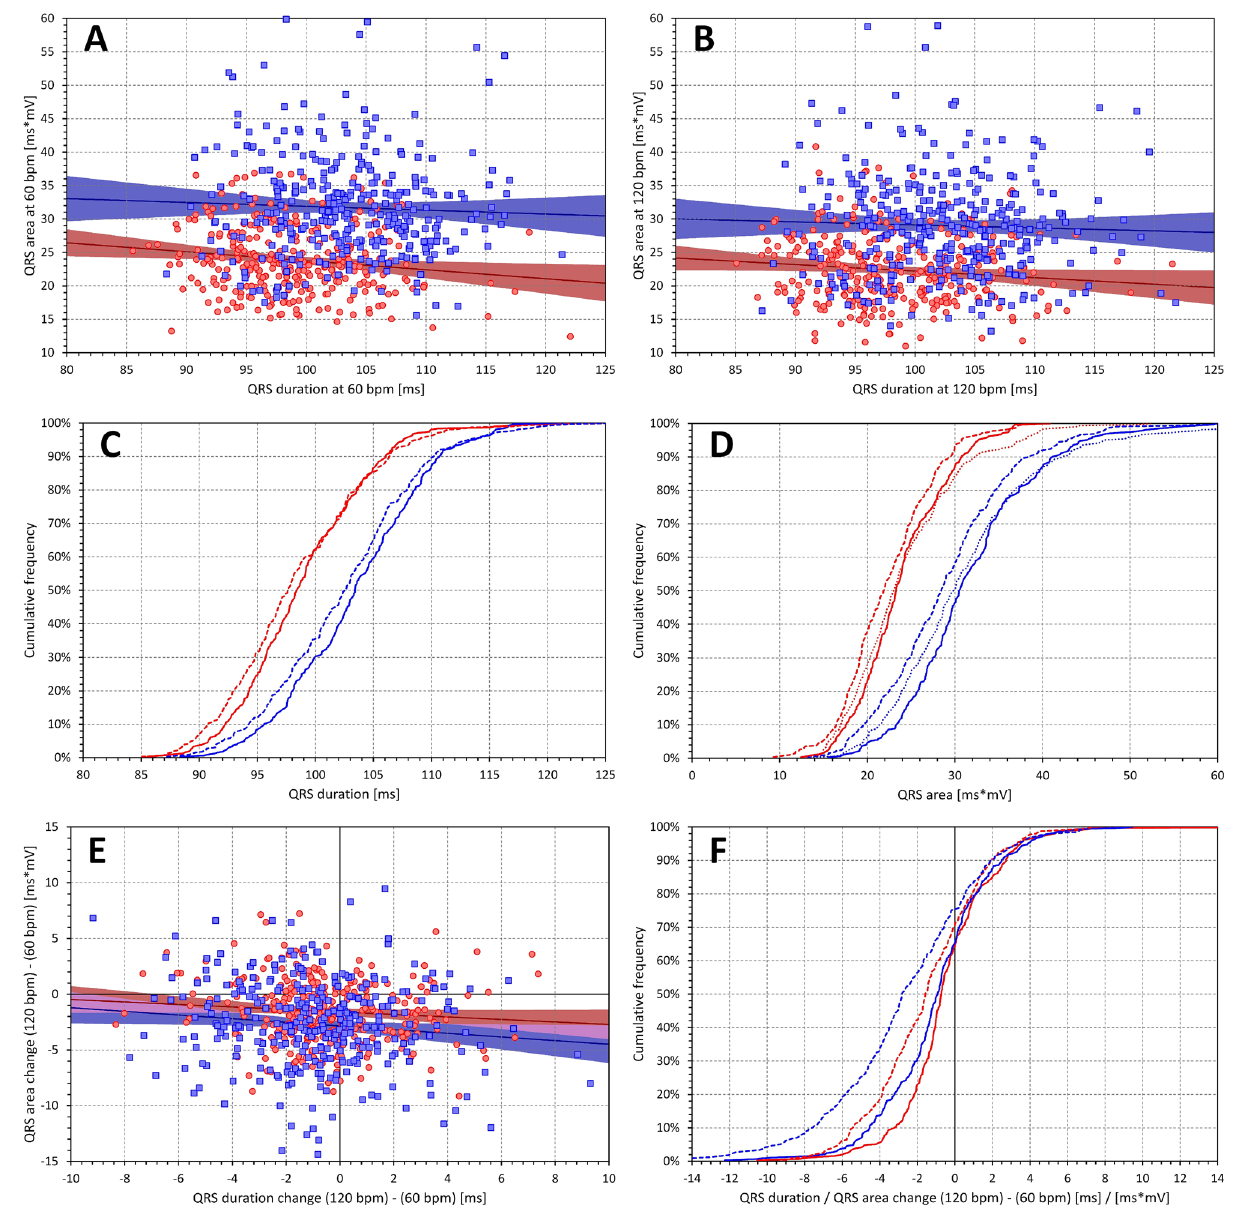
Figure 6. Data of QRS duration and of absolute QRS area. Panels ( A ) and ( B ) show the scatter diagrams of the relationship between the QRS duration and the absolute QRS area at heart rates of 60 and 120 bpm, respectively. Panels ( C ) and ( D ) show the cumulative distributions of QRS duration and of absolute QRS area. Panel ( E ) shows the scatter diagram of the relationship between intra-subject changes of QRS duration and of absolute QRS area corresponding to heart rate changes between 60 and 120 bpm and panel ( F ) shows the cumulative distributions of these intra-subject changes. In panels ( A ), ( B ), and ( E ), the red circles and blue squares show data of female and male subjects, respectively. The solid red and solid blue lines show the linear regressions between the displayed values in females and males, respectively. The red shaded and blue shaded areas are the 95% confidence intervals of the regression lines; the violet areas are the overlaps between the confidence intervals of the sex-specific age-regressions. In panels ( C ), ( D ), and ( F ), the red and blue lines correspond to female and male subjects, respectively. In panels ( C ) and ( D ), the full lines and dashed lines correspond to the values at 60 and 120 bpm, respectively. The dotted lines in panel ( D ) show the values at QRS duration of 100 ms. The full and dashed lines in panel ( F ) show the changes of QRS duration and of absolute QRS area,